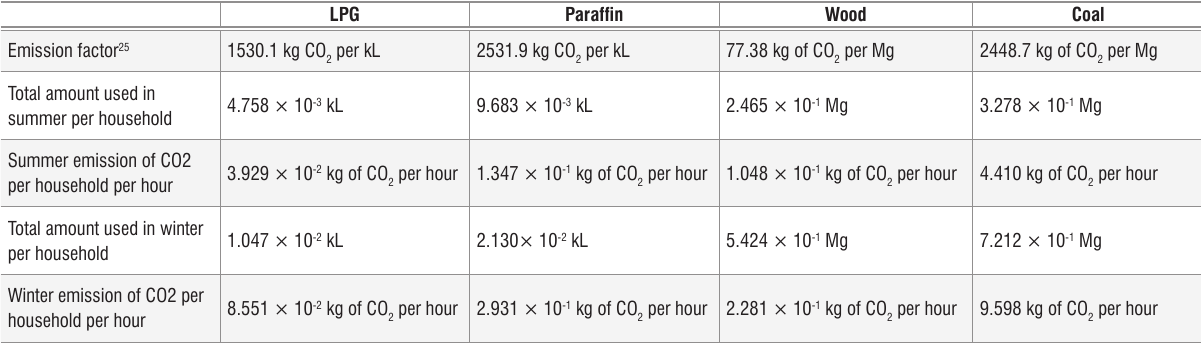
Source: Total fuel usage figures were obtained from the 2009 Energy Digest published by the South African Department of Energy 16 and estimates of households in South Africa and in the Cape Town area were obtained from the 2011 South African Census 7